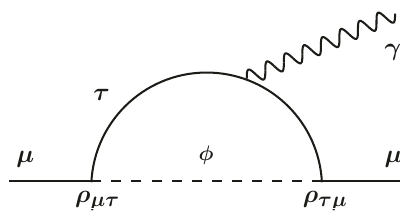
Figure 1 . One-loop digram for µ